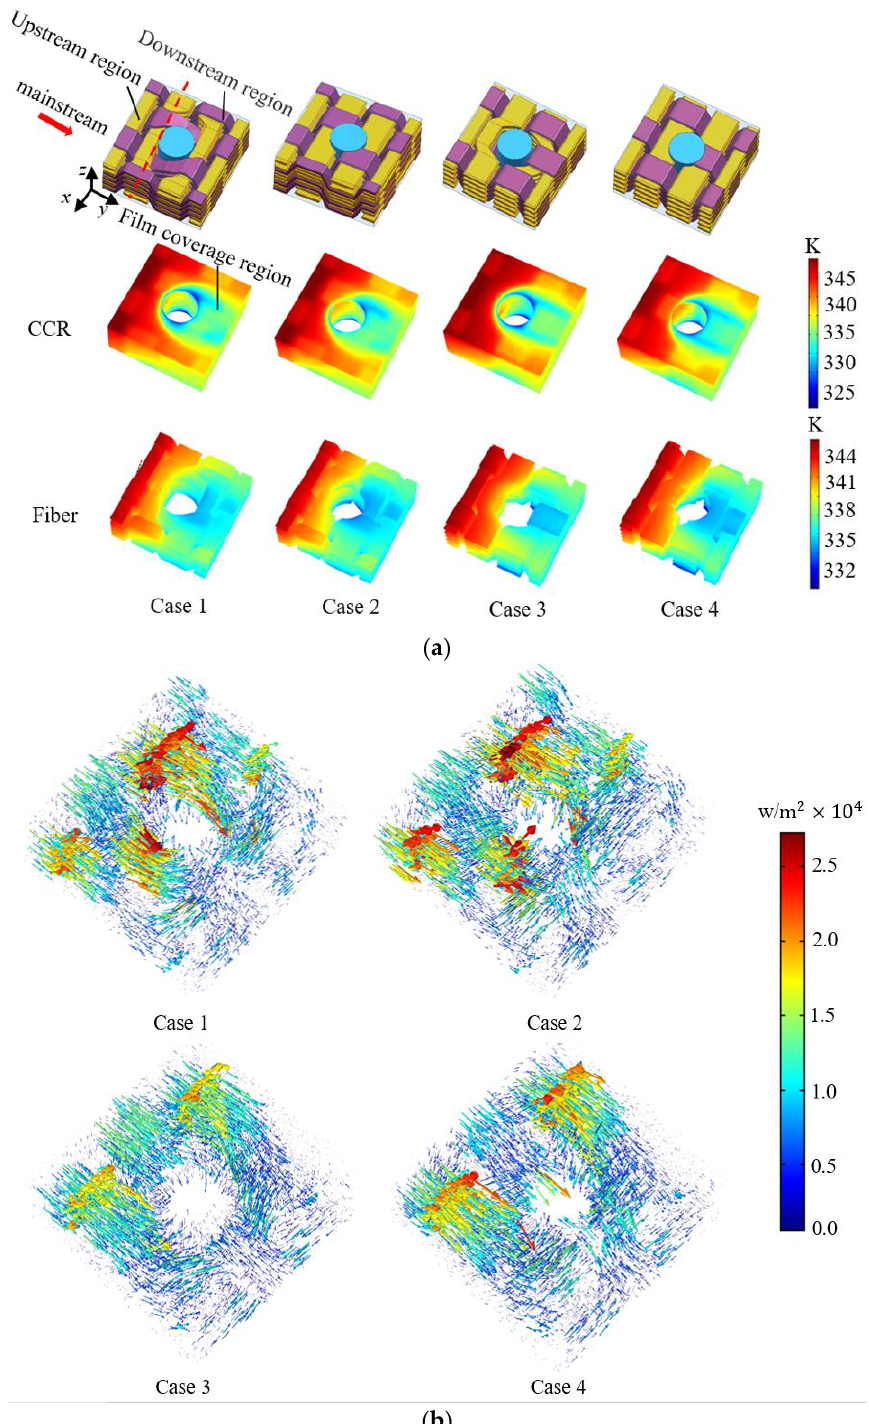
Figure 12. Temperature fields and heat flux direction of different cases on CCR: ( a ) temperature fields of different cases on CCR, ( b ) flux direction of different cases on CCR.